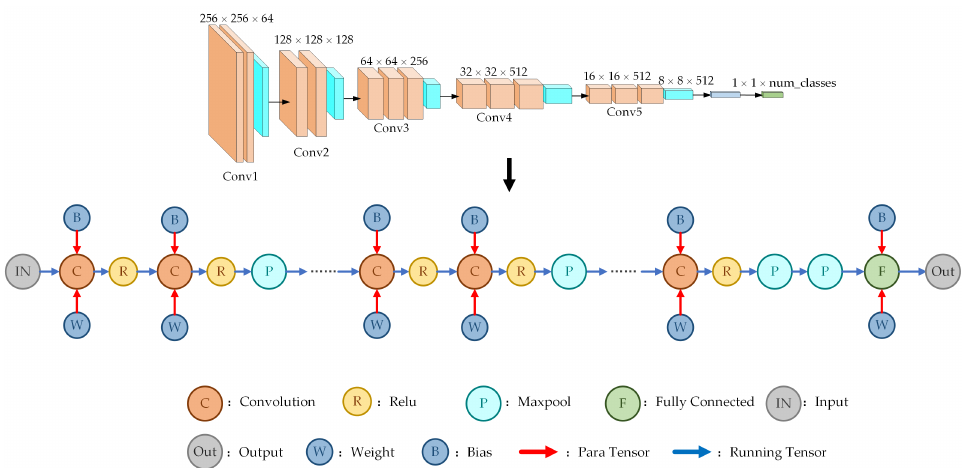
Figure 13. The compute graph representation of the improved VGG16